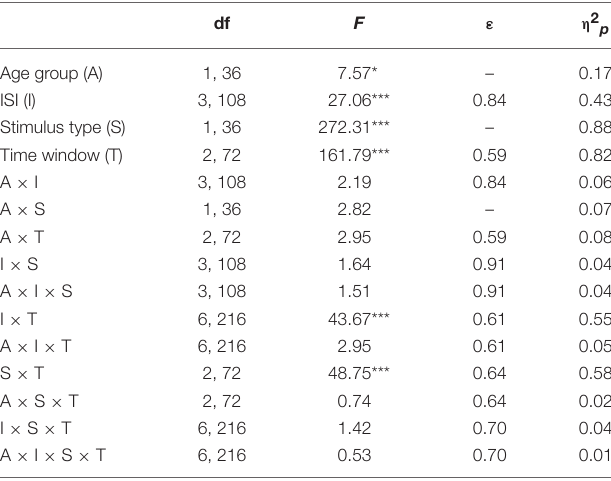
TABLE 1 | Statistical evaluation of the group effect (19–39 vs. 55–78 years) and the effects of the repeated-measure factors Stimulus type (standard vs. novel), ISI (10, 5, 3, or 0.5-s ISI condition), and Time window (70–160, 160–250, or 250–450ms) on the global field power by means of analysis of variance